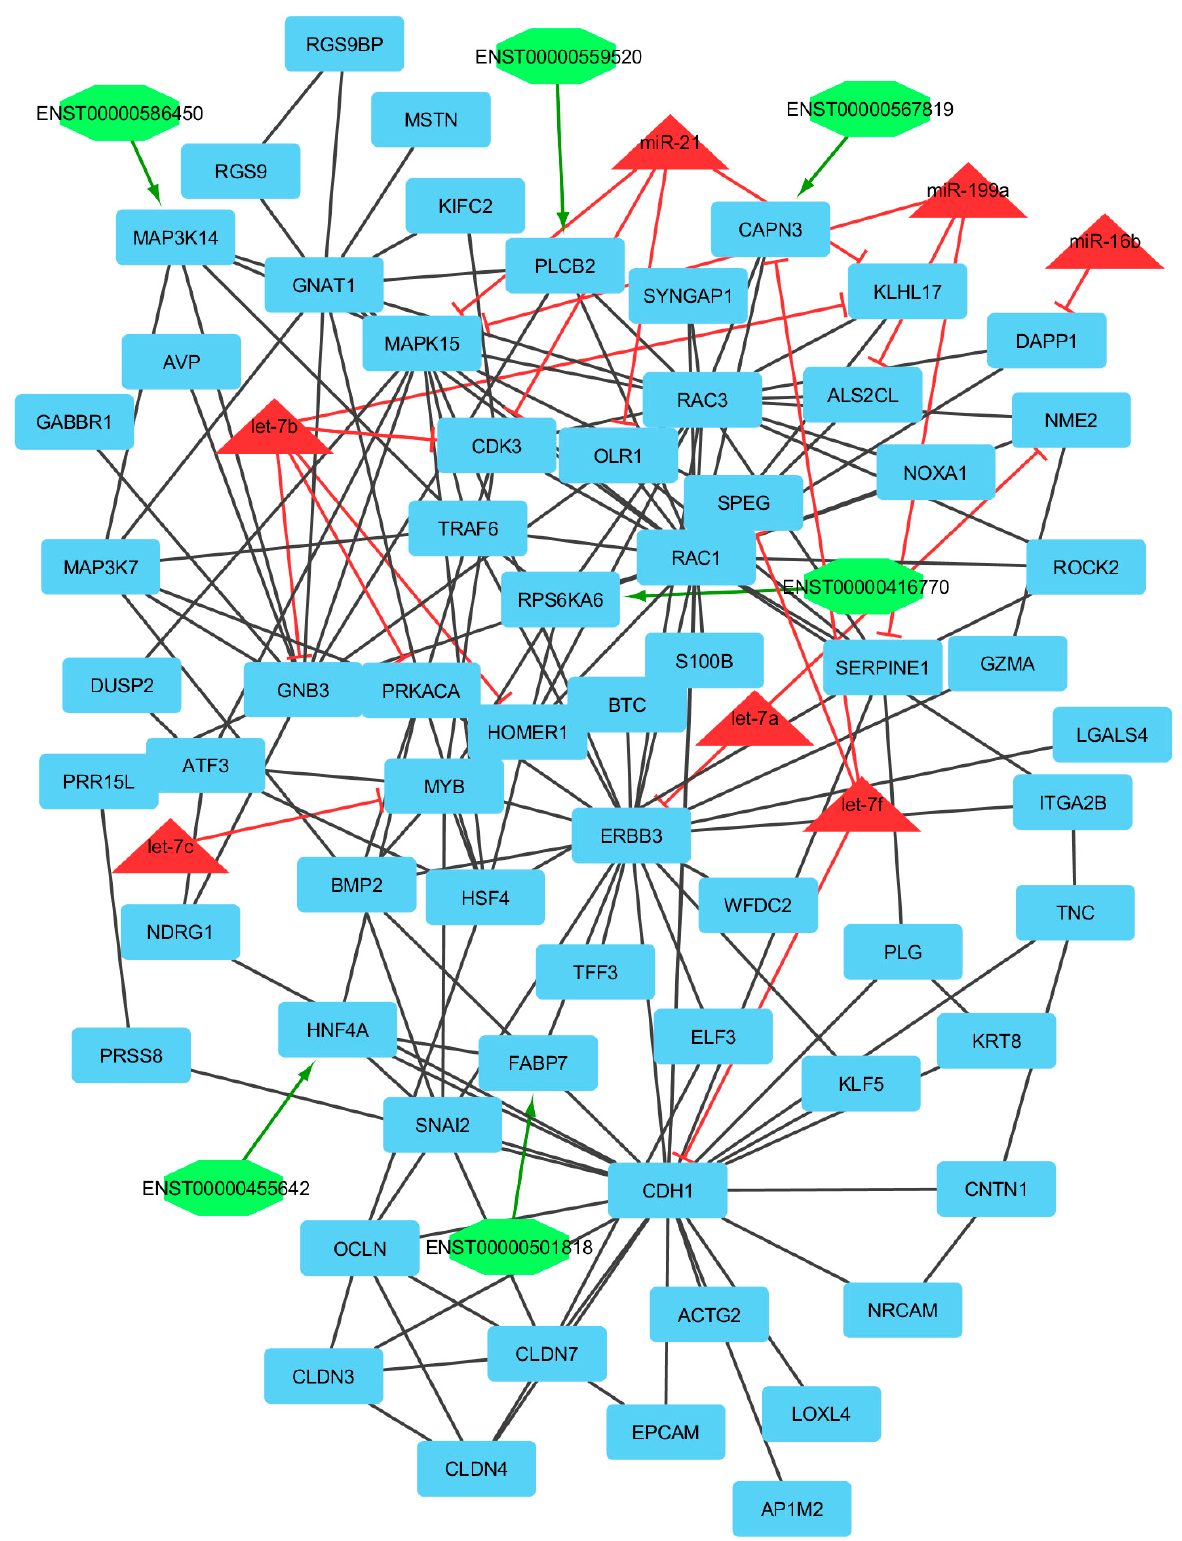
Figure 7. Module 4: 65 mRNAs/genes, 6 lncRNAs, and 7 miRNAs in an interacted network were identified. In this network, the quadrilateral nodes represent mRNAs/genes, octagonal nodes represent lncRNAs, and triangle nodes represent miRNAs. Edges indicate the interactions; black edges represent mRNA–mRNA interactions, green edges represent lncRNA–mRNA interactions, and red edges represent miRNA–mRNA